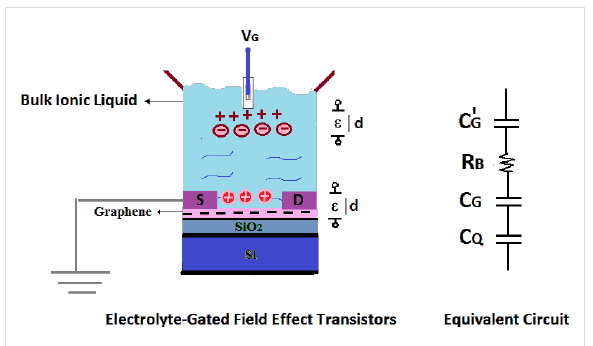
Figure 2: A cross-section of graphene-based electrolyte-gated field effect transistor, together with the equivalent electrical